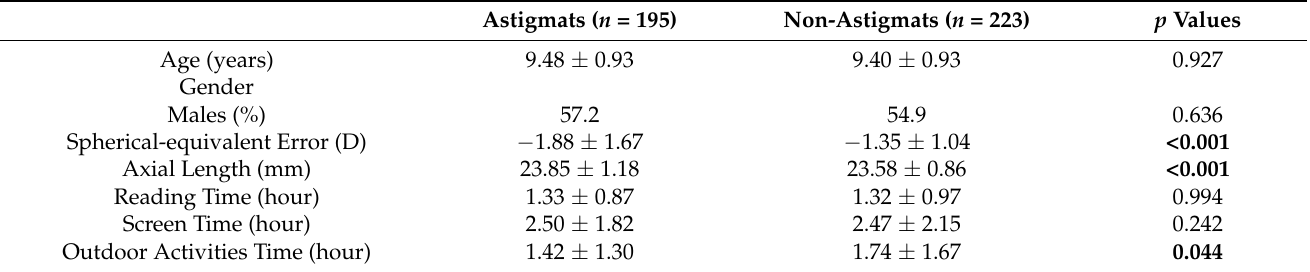
Table 2. Comparison of demographic information, myopia, and visual habits between astigmatic and non-astigmatic children. Bold values denote statistical significance ( p < 0.05).